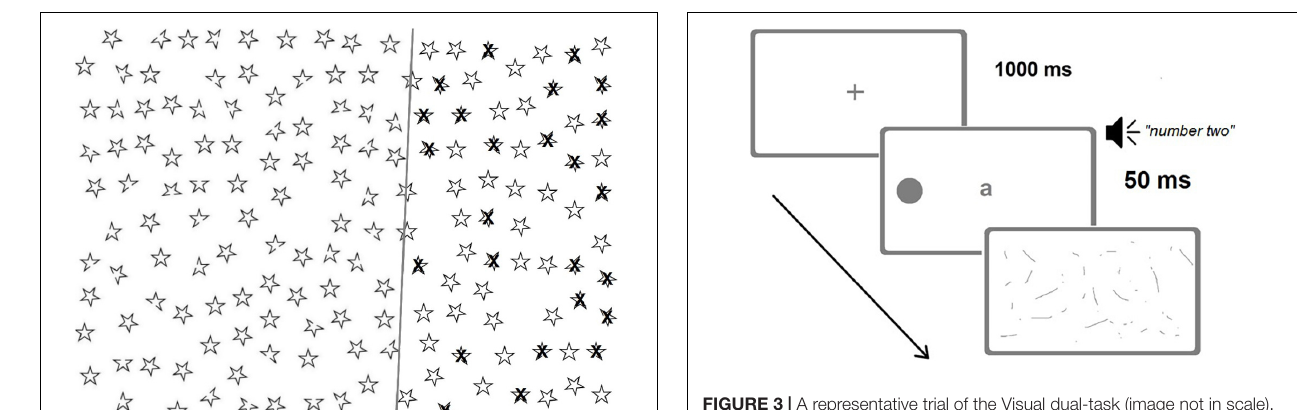
FIGURE 3 | A representative trial of the Visual dual-task (image not in scale). A left target (alternative positions possible: right or bilateral) is briefly presented (50 ms) concurrently with a central letter and an auditory digit. Correct responses for the Visual dual-task would have been “a” (central letter) and “left” (target position), while for the Auditory dual-task they would have been “four, six” (count in steps of two from the auditorily presented “two”) and “left.” (Adapted from Bonato,